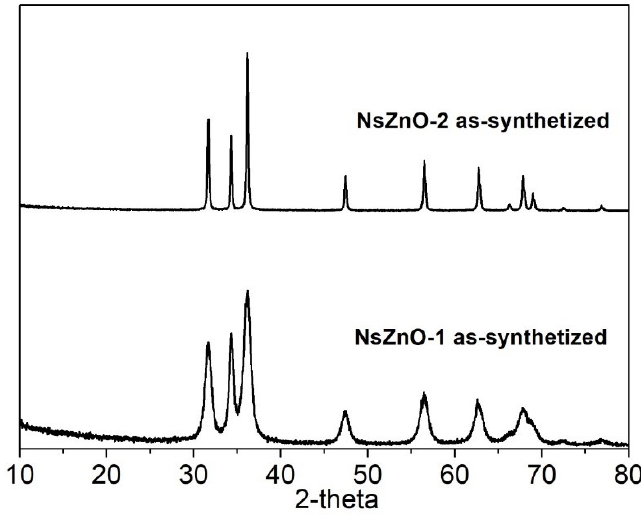
Figure 3. XRD patterns of NsZnO-1 and NsZnO-2.